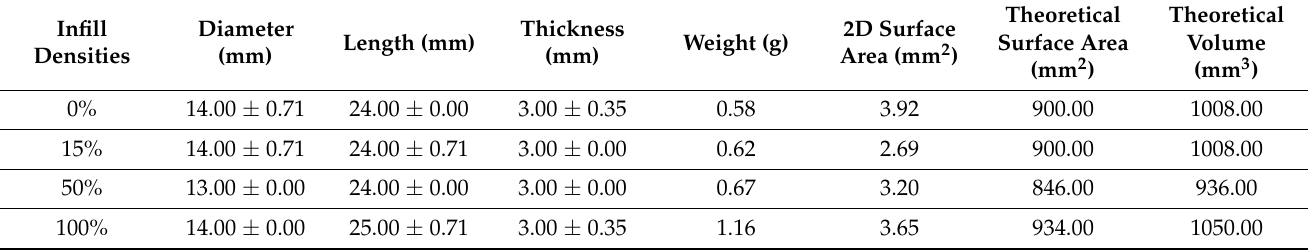
Table 5. Different infill densities of 3D-printed gummy bear shape tablets (design 4). Data for diameter, length, and thickness represent the mean ± standard deviation (SD), where n =